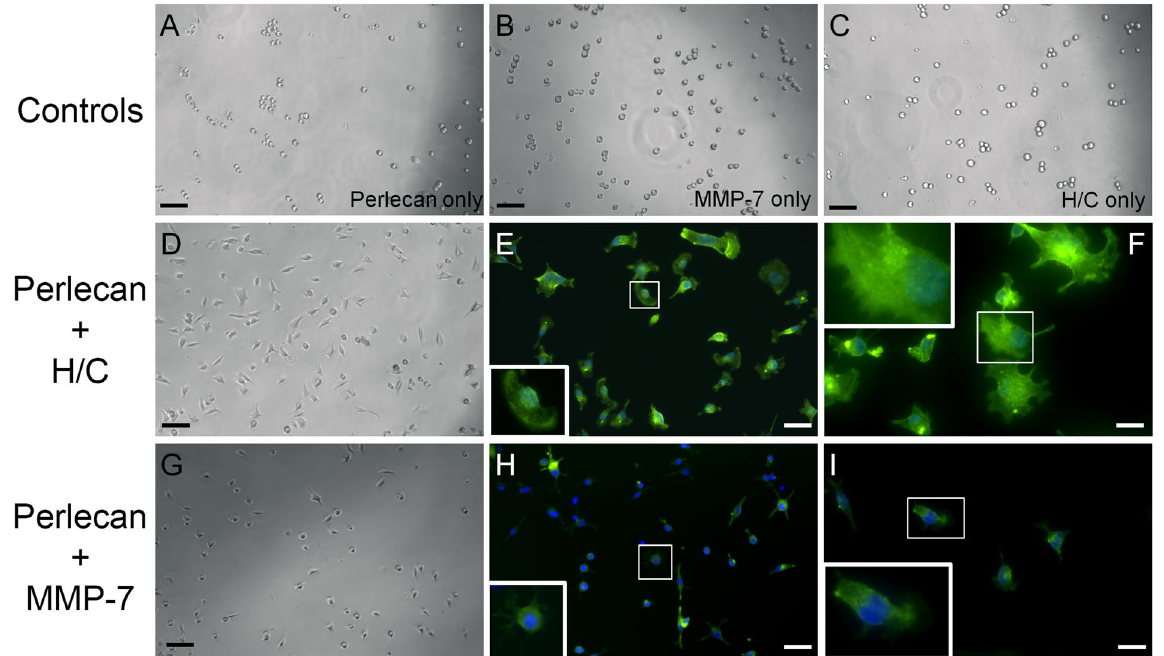
Figure 2. Heparanase/chondroitinase and MMP-7 enzymatic processing of perlecan favors cell substratum versus cell-cell adhesion. C4-2B cells were seeded onto various types of perlecan and control samples pre- adsorbed to the plate and imaged by bright field microscopy and then stained for F-actin (green) and nuclei (blue) after 1 hour. Perlecan digested with a mixture of heparitinase and chondroitinase ABC (H/C) (panels D–F) or MMP-7 (panels G–I) adhered to the plates within one hour and remained attached through the staining procedure ( E , F and H , I ). Neither intact perlecan ( A ), MMP-7 alone ( B ), nor H/C mixture alone ( C ) supported this rapid adherence to substratum, and cells remained round or formed loose clusters. Boxed insets provide an enlarged image to show cell morphology. Scalebars: 100 µ m for A-D and G; 50 µ m for E and H; 25 µ m for F and